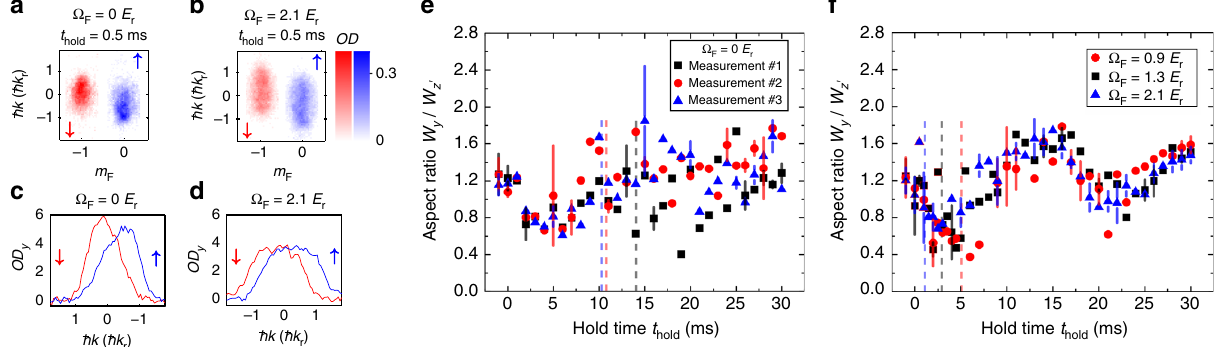
Fig. 5 Observation of deformed atomic clouds and BEC shape oscillations. a – d Observation of deformed atomic clouds at early stages of the SDM. a , b TOF images for Ω F = 0 and Ω F = 2.1 E r at t hold = 0.5 ms are shown for comparison. The corresponding integrated optical density ( OD y ) versus the momentum in the SOC direction ^ y ð Þ for the spin down and up components is shown respectively in c , d . e , f Observation of BEC shape oscillations. The data showing the aspect ratio W y / W z ′ (see Methods) of the condensate measured at various t hold are extracted from the SDM measurements in Fig. 3, except for the additional measurements #2 and #3 in e . e For the three independent measurements in the bare case, the observed oscillations possess a complicated behavior without having a well-de fi ned frequency given the error bars and the fl uctuation in the data. Select TOF images for measurement #1 are shown in Fig. 2a. f In the dressed cases, aspect ratio oscillations with a well-de fi ned frequency are observed in measurements at three different Ω F . The average frequency of the three aspect ratio oscillations obtained from the damped sinusoidal fi t is around 58 Hz, consistent with the expected frequency for the ffiffiffiffiffiffiffi p ω = ð 2 π Þ (cid:4) 59 Hz for a cigar-shape BEC in the limit of ω ω fi ed by Raman lasers 52 . Note that ω m = 0 quadrupole mode f m 2 : 5 z / x , y << 1 z is not modi z ¼ 0 ¼ and thus does not depend on Ω F . Select TOF images for Ω F = 1.3 E r are shown in Fig. 2b. The representative error bars in ( e , f ) are standard deviation of at least three measurements. The dashed lines indicate t hold ~ 2 τ damp after which the SDM is fully damped